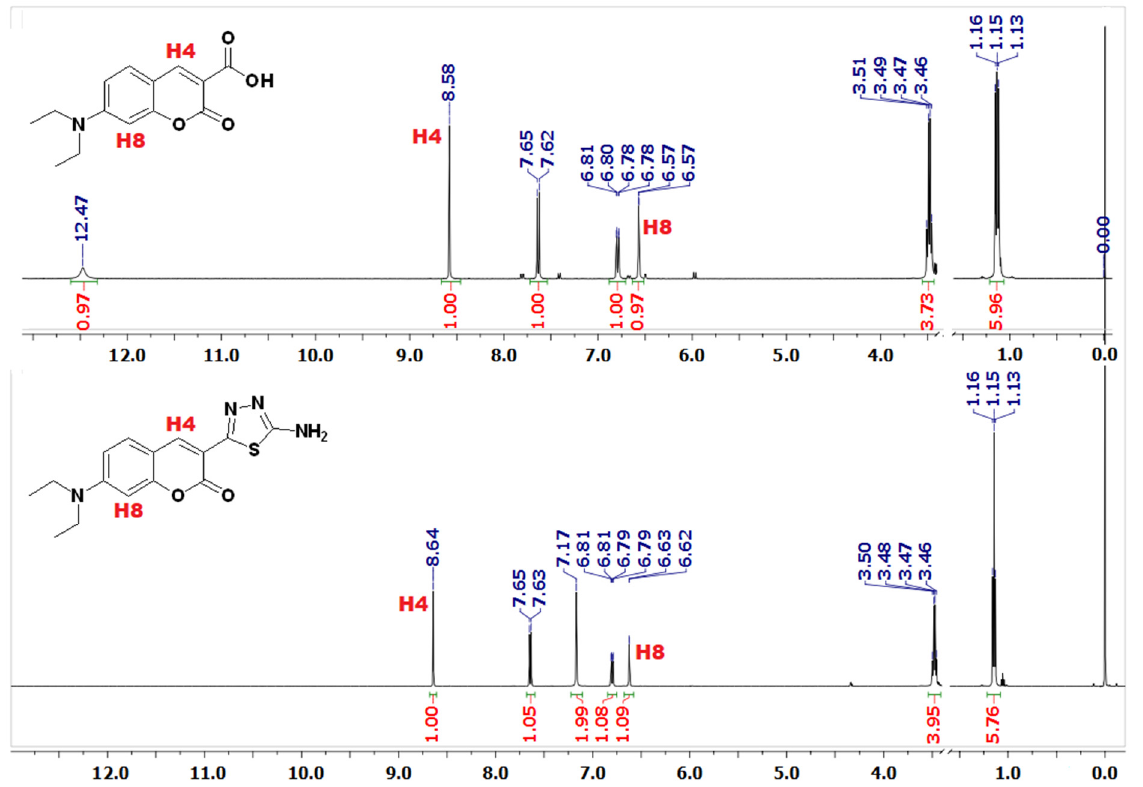
Figure 6. Comparison of the 1 H-NMR (DMSO d6 ) spectra of coumarin-3-carboxylic acid 1 ′ ( top ) and the corresponding coumarin–thiadiazole hybrid 1 ( bottom ). The most informative signals, namely the hydrogens H4 and H8, are marked in red. For better clarity, the residual solvent and water peaks were omitted.